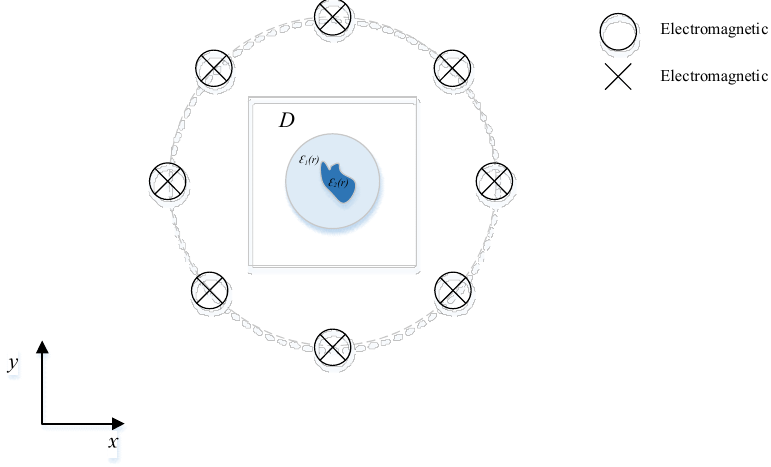
Figure 1. Electromagnetic inverse scattering model.